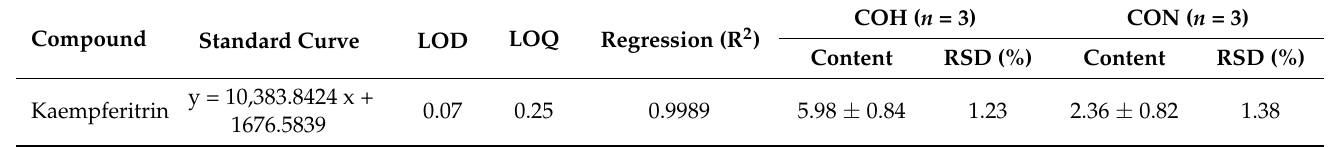
Table 2. Kaempferitrin of standard curve, LOD (nmol/kg), LOQ (nmol/kg) and the content of